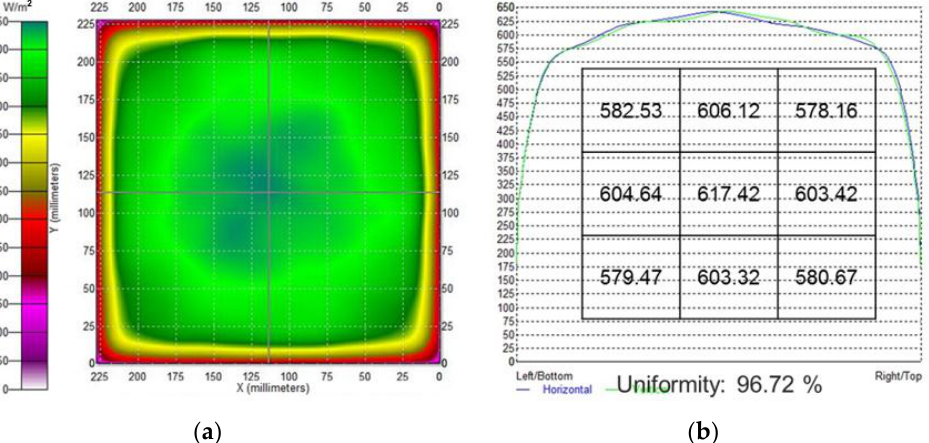
Figure 21. Simulation results after adjustment LED power: ( a ) Results of adjustment LED power, ( b ) Uniformity of adjustment LED power.